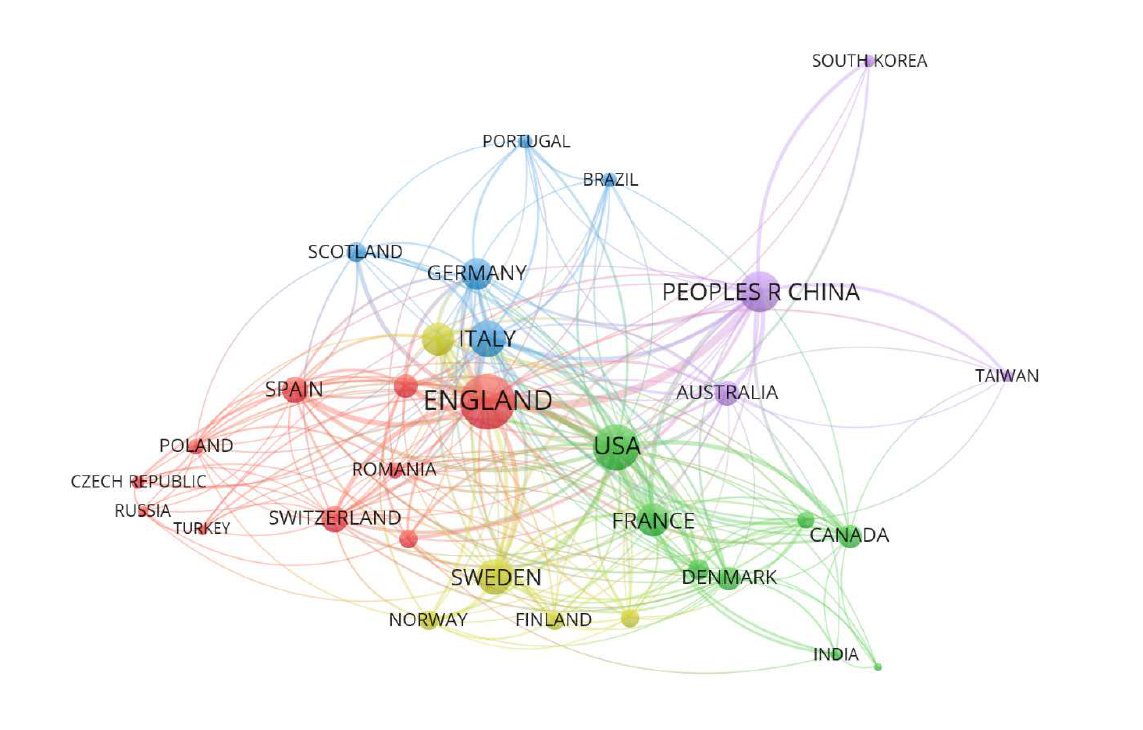
Figure 4. Cluster map of countries/regions on sustainable development in the sharing